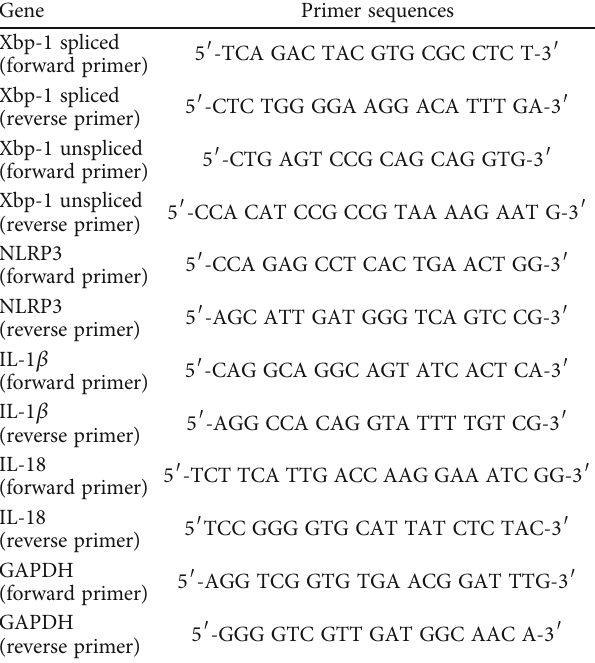
Table 2: RNA primer